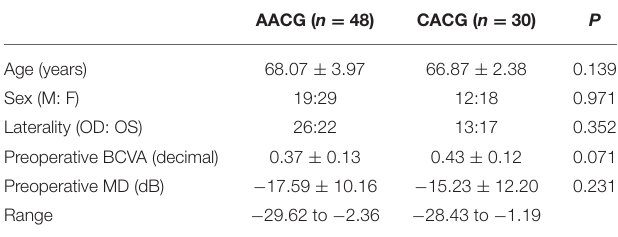
TABLE 1 | Patients characteristics. TABLE 2 | The changes of preoperative and 1-year postoperative clinical